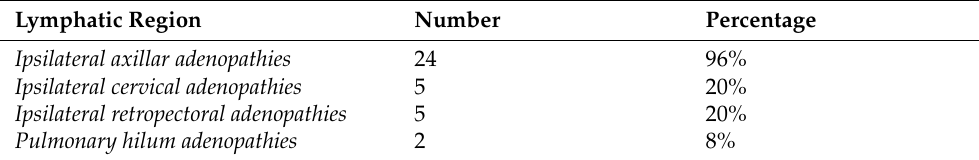
Table 2. Reported findings on PET-CT examinations, according to the lymphatic region.